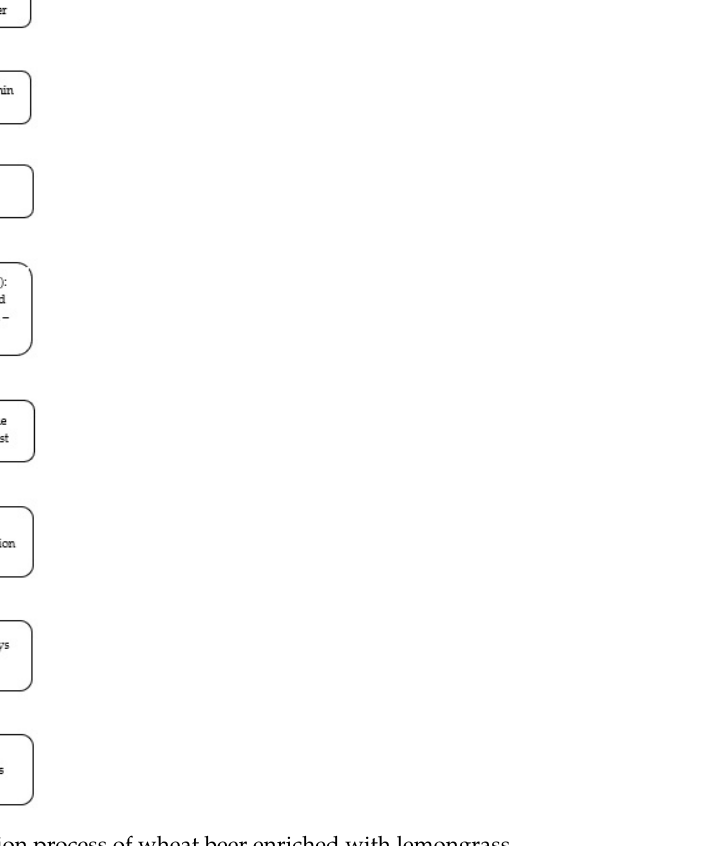
Figure 3. Production process of wheat beer enriched with lemongrass.